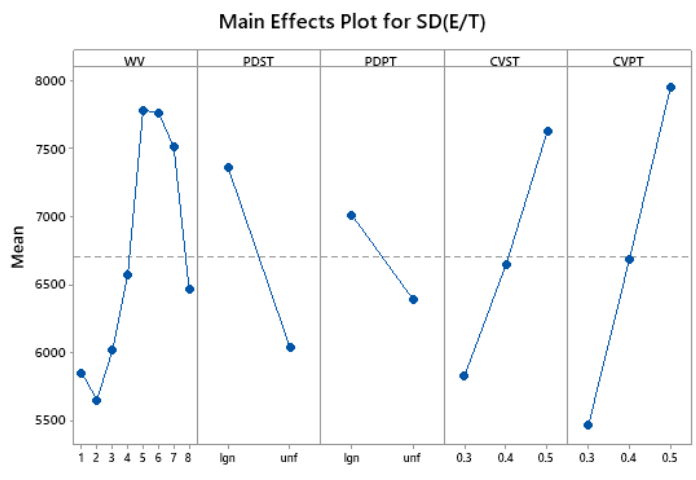
Figure 3. Main effects plots for E[E/T].